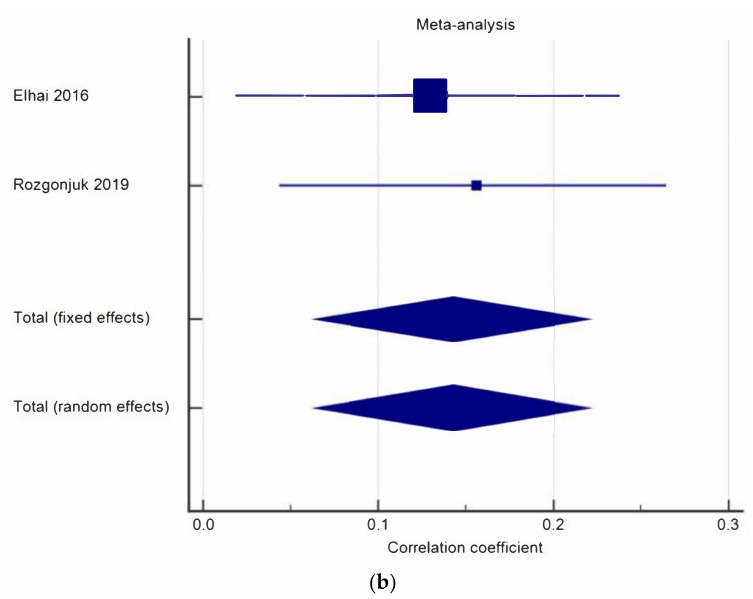
Figure 6. ( a ) Meta-analysis on the ERQ—SAS subgroup on the domain of “expressive suppres- sion” [40,52]; ( b ) forest plot showing the relationship between emotional dysregulation and PSU in studies using ERQ (“expressive suppression” domain) and SAS scales